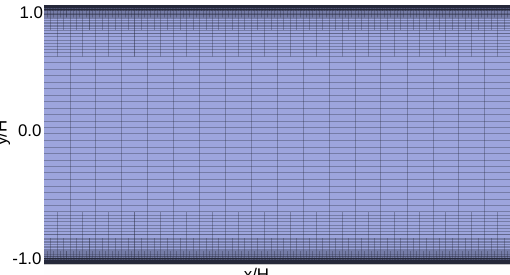
Figure 2. Computational grid used to perform the electro-osmotic fluid flow. The mesh is in scale. At the center of the grid ∆ x / H = 0.2. This mesh has 8 levels of